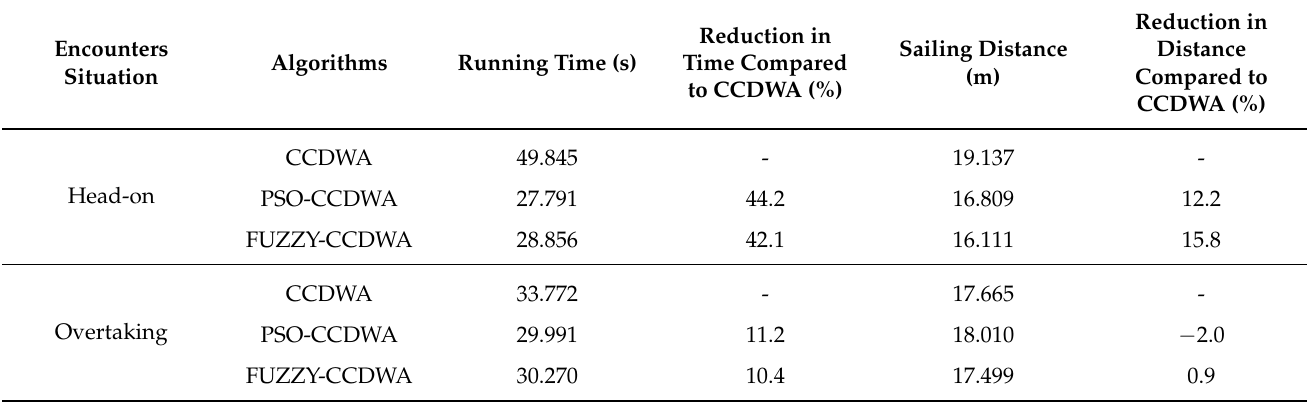
Table 6. Initial parameters of the DWA